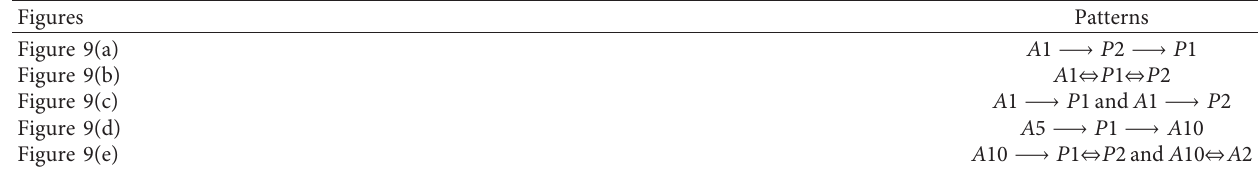
Table 4: The list of the flow patterns inferred from intercity